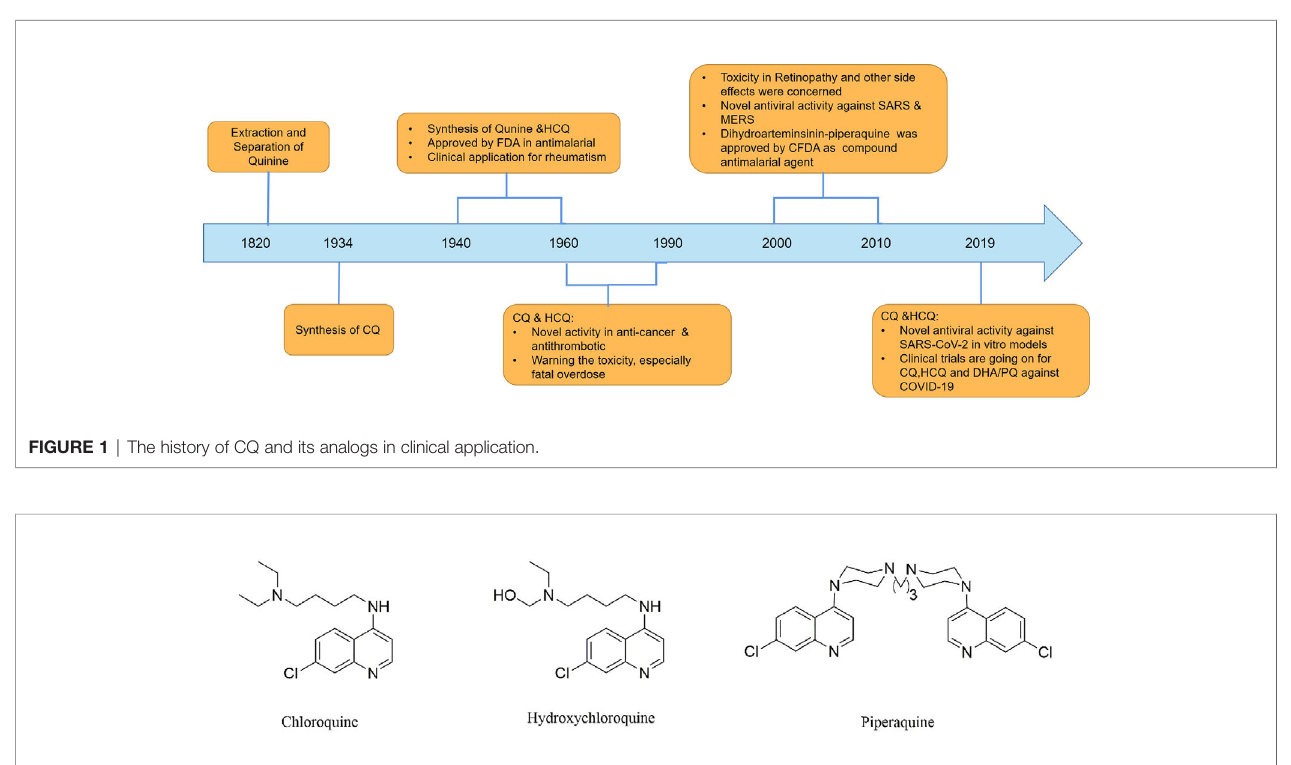
FIGURE 2 | The structure of CQ and its analogs. Hydroxychloroquine differs from CQ by the presence of a hydroxyl group on one of the ethyl groups attached to nitrogen in the side chain. Piperaquine, which share the bisquinolines structure, may be more ef fi ciently trapped in the acidic digestive vacuole and thus inhibit coronavirus entry and